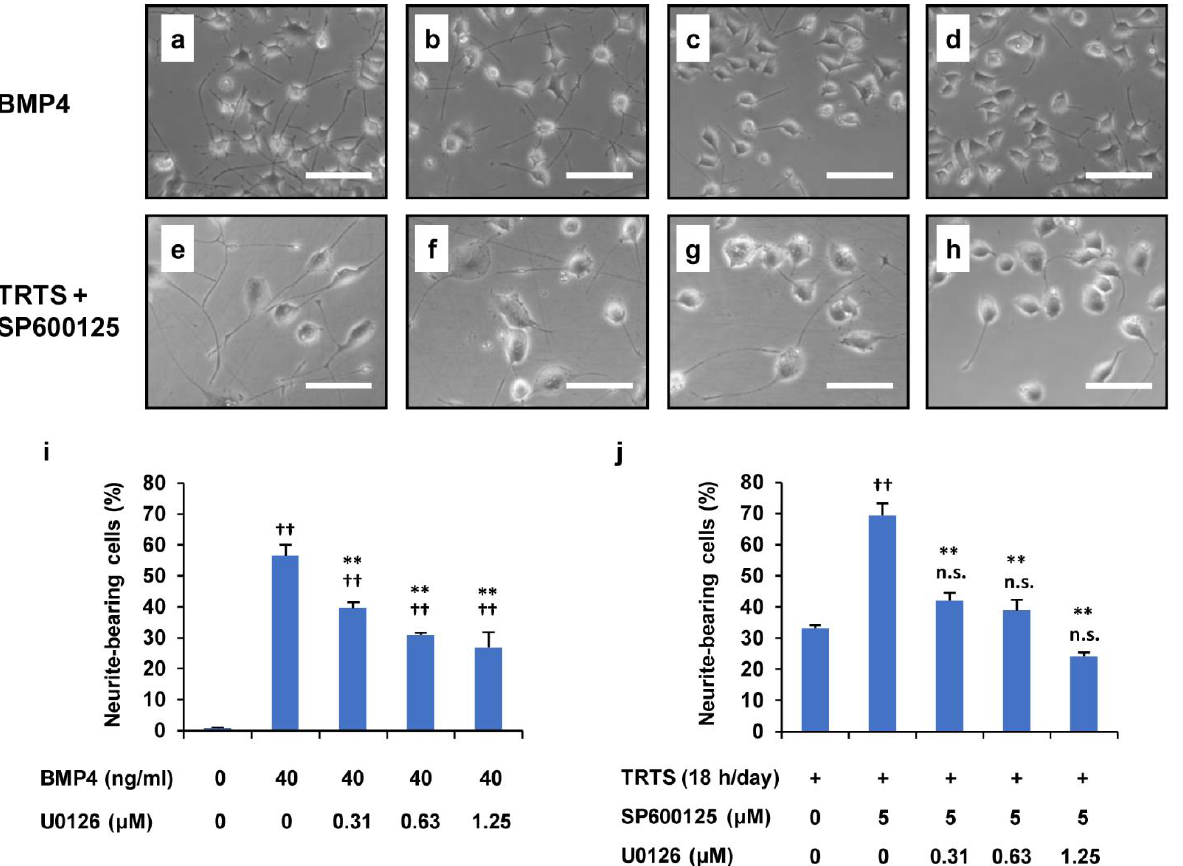
Figure 8. Suppression of TRTS plus SP600125-mediated neuritogenesis by U0126 in PC12-P1F1 cells. ( a – d ) PC12-P1F1 cells were treated with 40 ng/mL bone morphogenetic protein 4 (BMP4) as a control for 7 days in the presence or absence of U0126. Representative phase-contrast images of PC12-P1F1 cells on day 7 after treatment with ( a ) 0 μM, ( b ) 0.31 μM, ( c ) 0.63 μM, and ( d ) 1.25 μM U0126. ( e – h ) PC12-P1F1 cells were exposed to TRTS plus SP600125 for 7 days in the presence or absence of U0126. Representative phase-contrast images of PC12-P1F1 cells on day 7 after treatment with ( e ) 0 μM, ( f ) 0.31 μM , ( g ) 0.63 μM, and ( h ) 1.25 μM U0126. Scale bars: 100 μm. ( i , j ) PC12-P1F1 cells were stimulated with 40 ng/mL BMP4 ( i ) or exposed to TRTS plus SP600125 ( j ) for 7 days, and the rate of neurite-bearing cells was determined on day 7. The data represent the means ± standard deviation of three replicates. †† p < 0.01 vs. control ( i ) or TRTS alone ( j ); ** p < 0.01 vs. BMP4 alone ( i ) or vs. TRTS plus SP600125 only ( j ); n.s., not significant vs. TRTS alone ( j ).